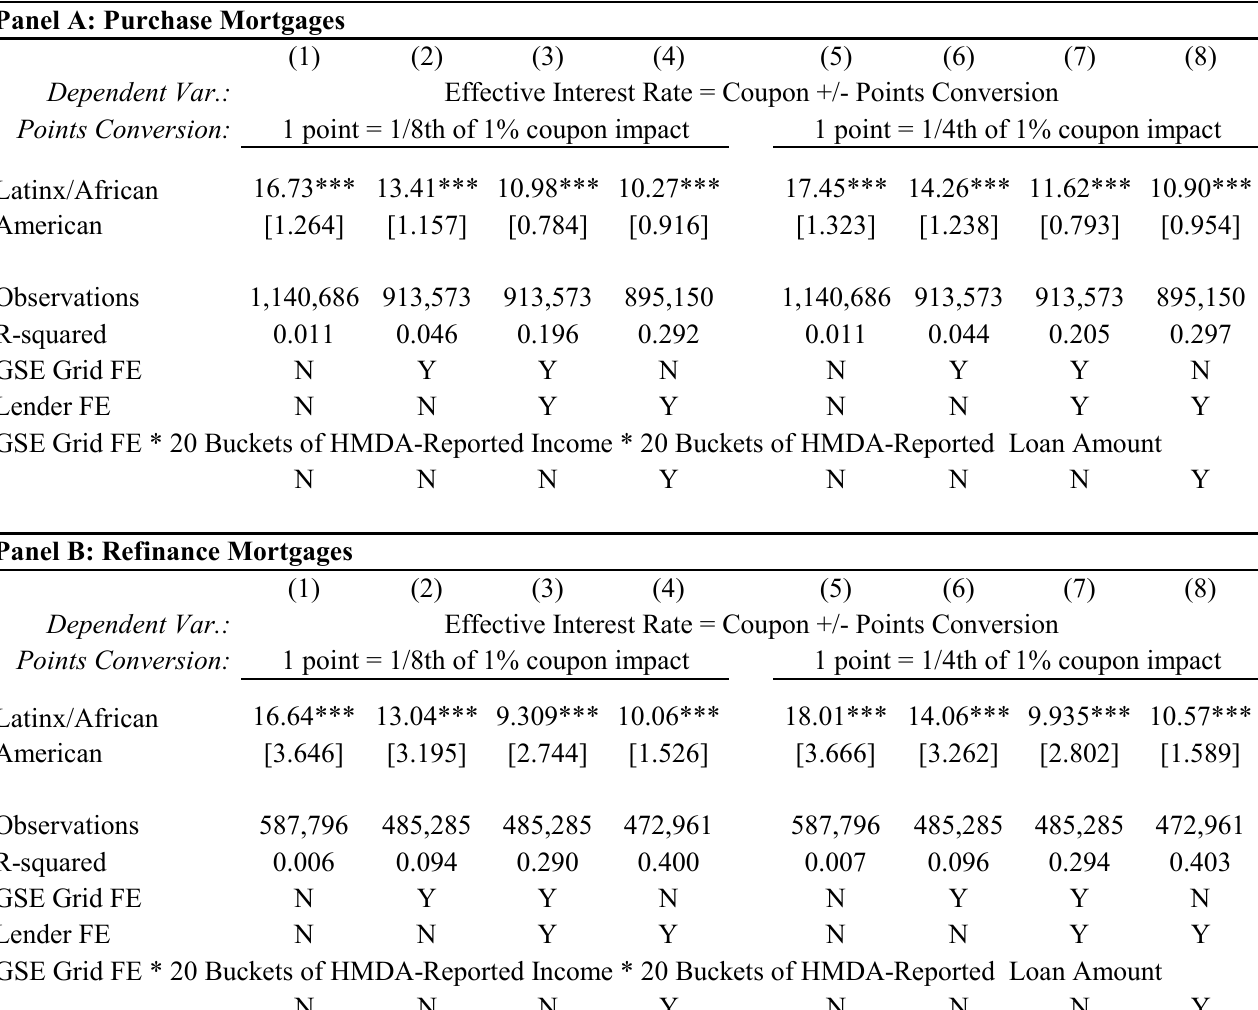
Table 6: HMDA 2018 Analysis with Points-Adjusted Interest